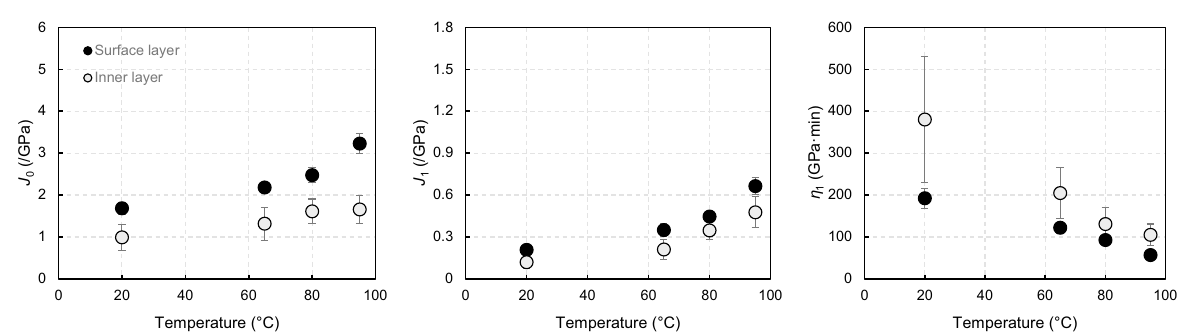
Fig. 8 Creep-recovery parameters of surface- and inner-layers of sugi boxed-heart timber at each temperature. The error bar indicates standard